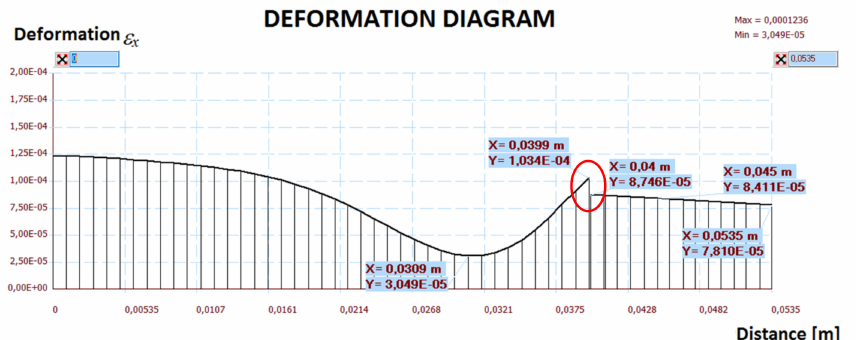
Figure 23. The diagram of horizontal deformations ε x in the II–II